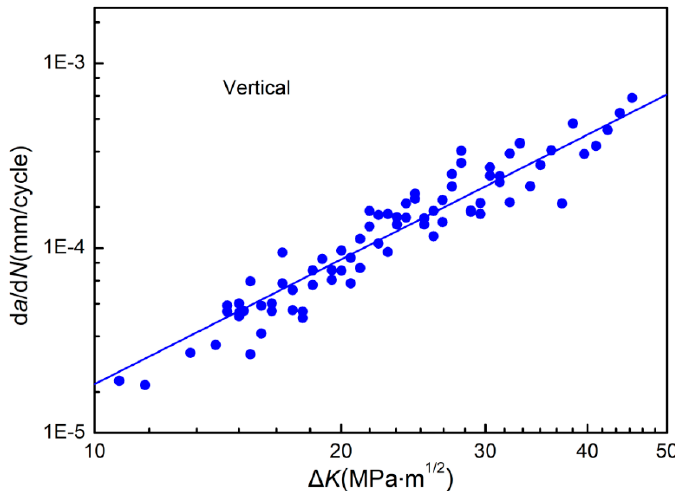
Figure 10. The relationship curve between the vertical fatigue crack propagation rate d a of SAAM workpieces and the SIF amplitude ∆ K.